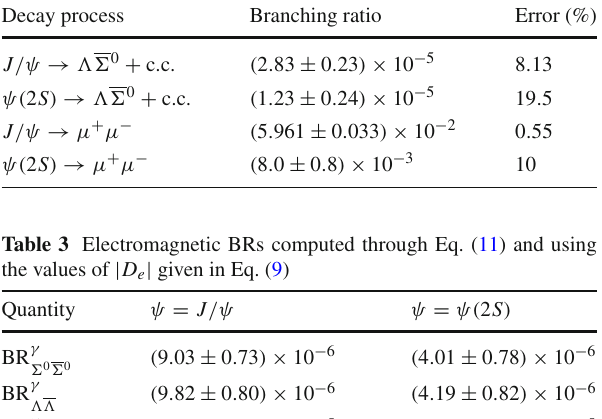
Table 2 Branching ratios data from PDG [5] Decay process